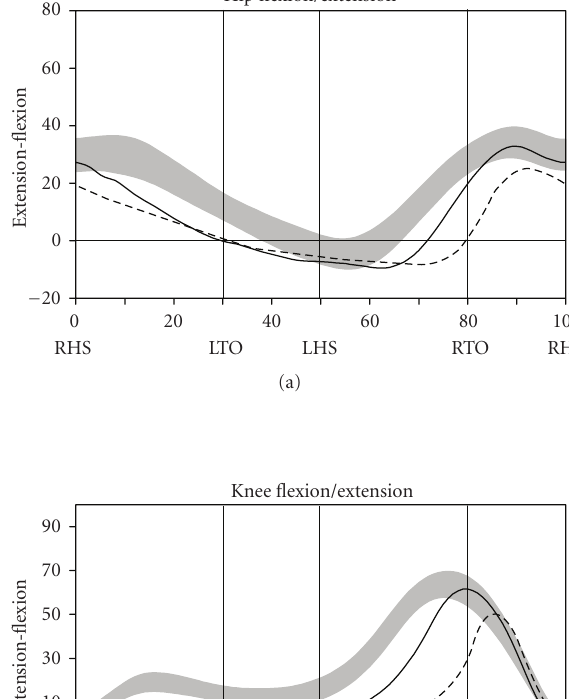
Figure 1: Muscle measurements before SAVT (April 21, 2007 to April 20, 2008) and after SAVT (started on April 21, 2008). Calendar date is along the x -axis and numerical measurements along the y - axis for peak power (watts), six-minute walk test distance (6MWT; metres), left mean grip strength (LMGS; pounds), and right mean grip strength (RMGS; pounds).